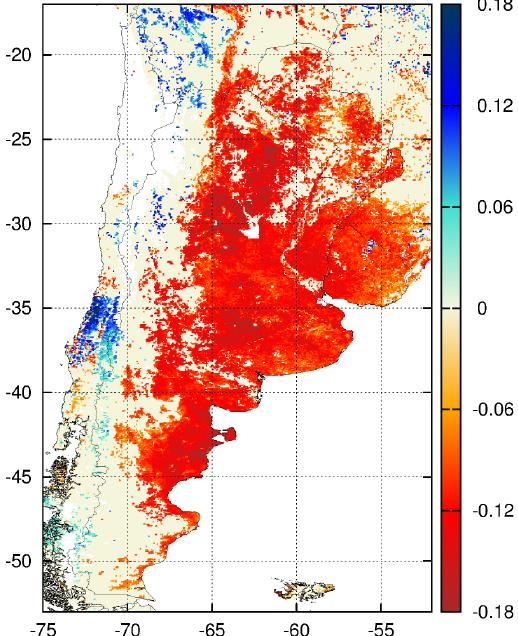
Figure 7. Enlargement view of the Indian Peninsula at the highest spatial resolution of 0 . 05 ◦ × 0 . 05 ◦ . Trends in units of year − 1 are color coded. Yellow circle locate the Indira Sagar Reservoir, approx. 22.17 ◦ N, 76.65 ◦ E (see the